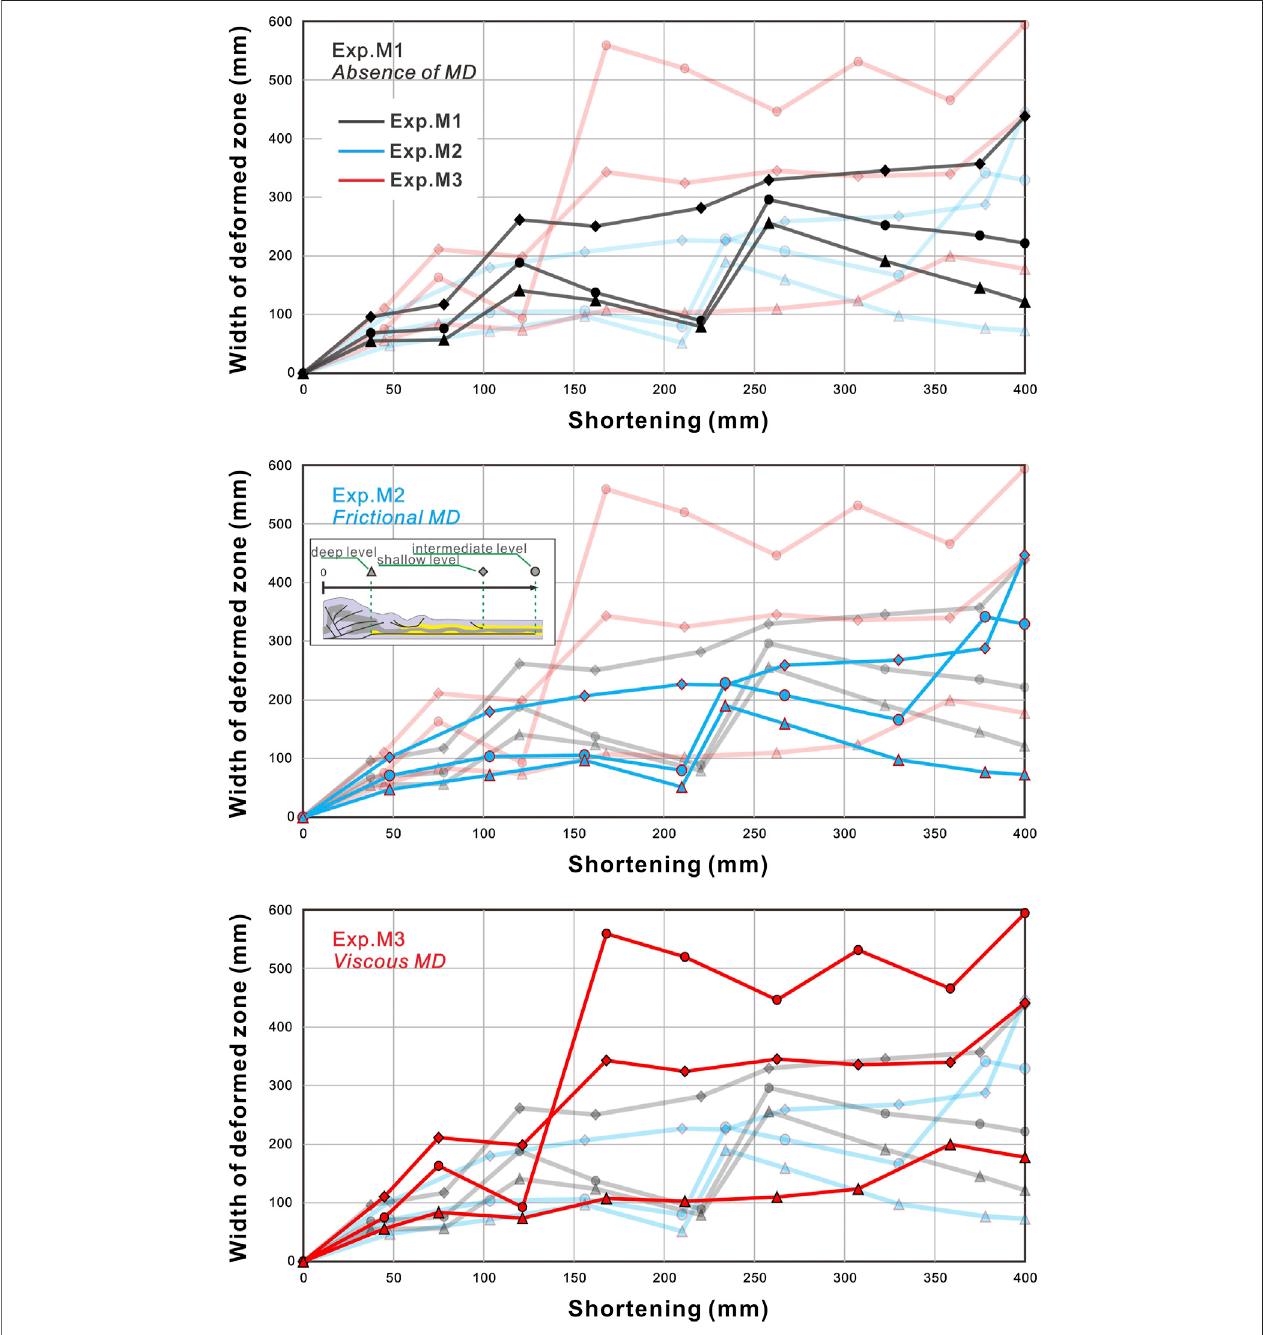
FIGURE 8 | Width curves of deforming zones in the three sandbox experiments. Each experiment has three curves to illustrate the difference in foreland-ward deformation propagation at different structural levels separated by the SD and MD. Approximating curves in one model indicate coupling between them. Otherwise, decouple